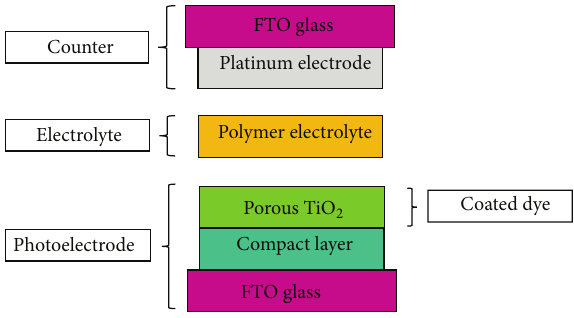
Figure 2: The DSSC